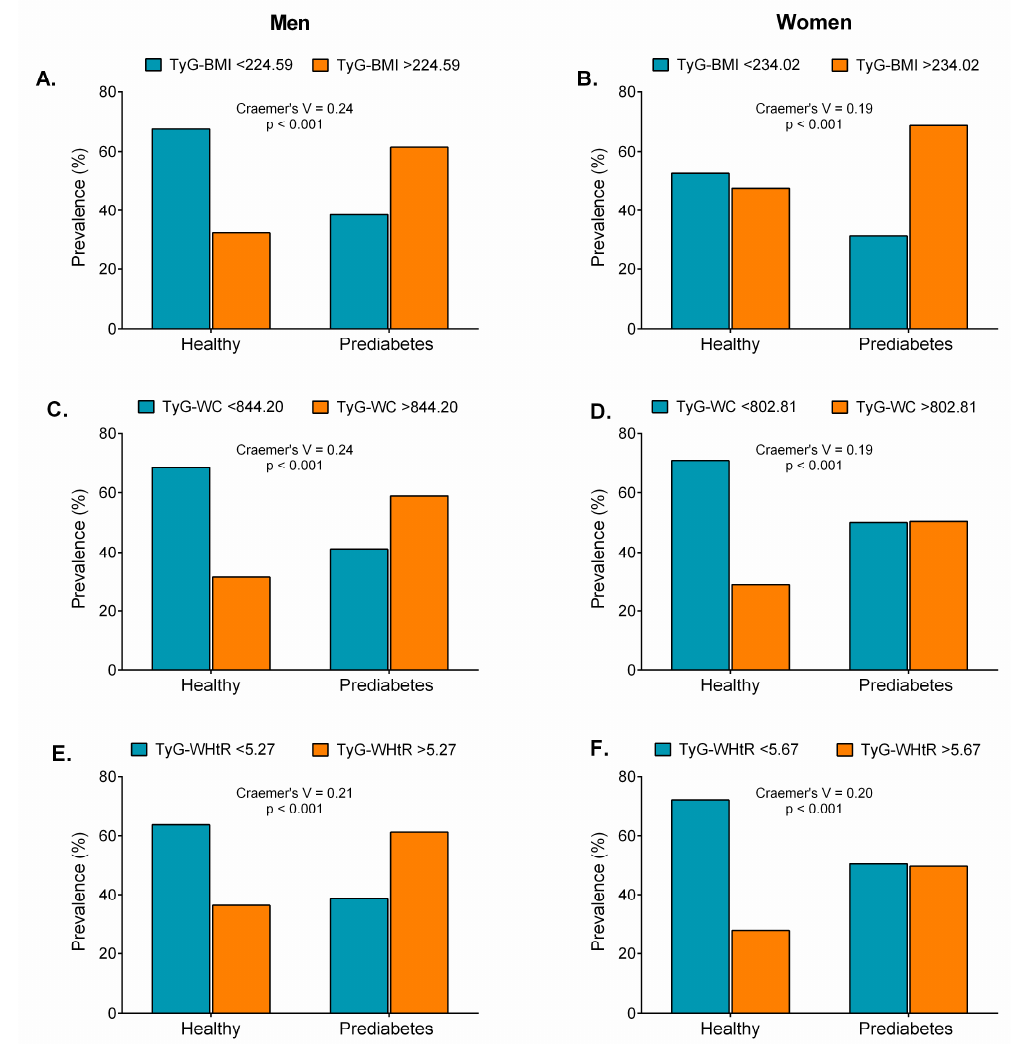
Figure 10. Prevalence of prediabetes according to obesity- and lipid-related index cut-offs (TyG-BMI, TyG-WC, and TyG-WHtR).